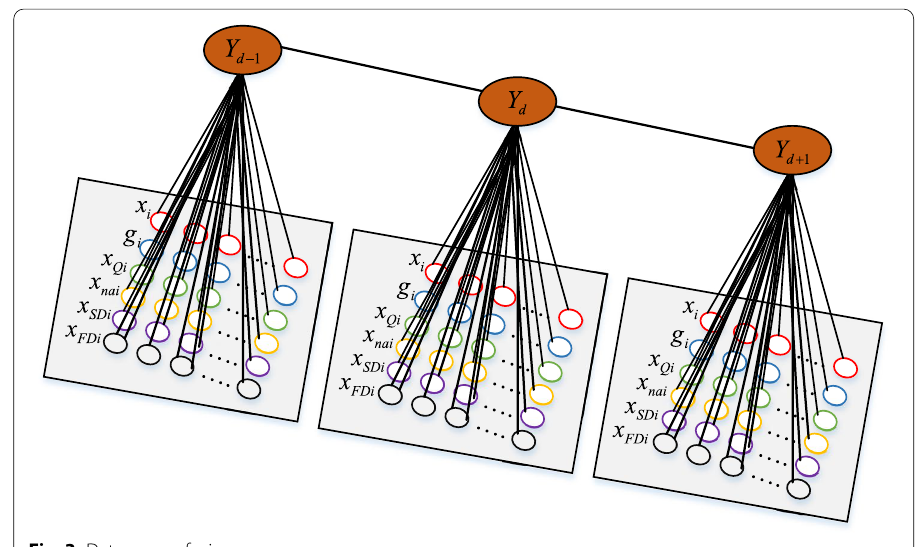
Fig. 3 Data source